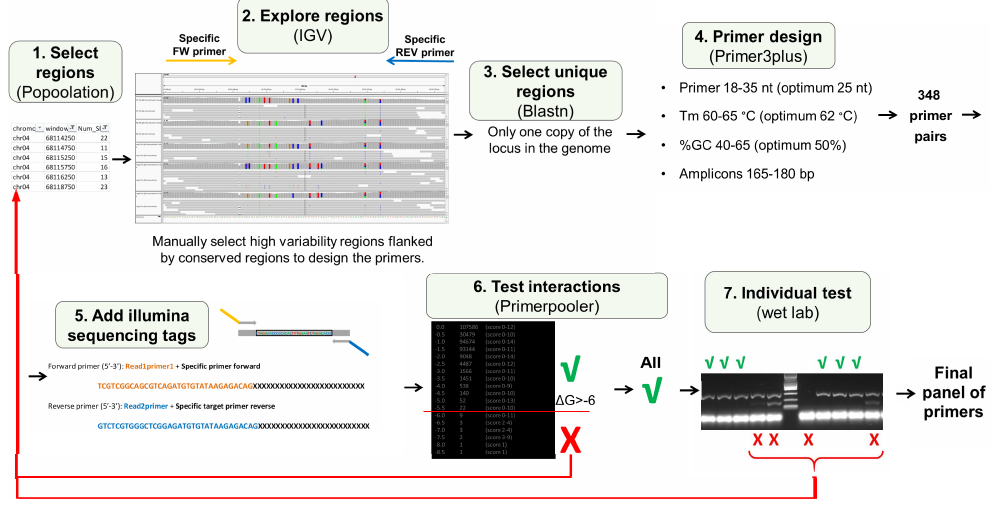
Figure 1. Pipeline for PotatoMASH primers design.